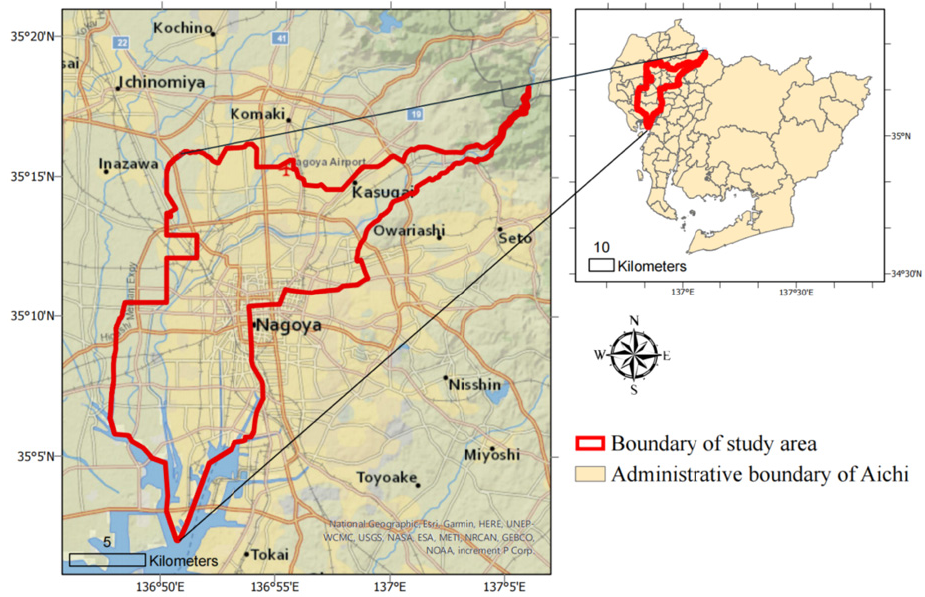
Figure 2. Geographical location of the study area.